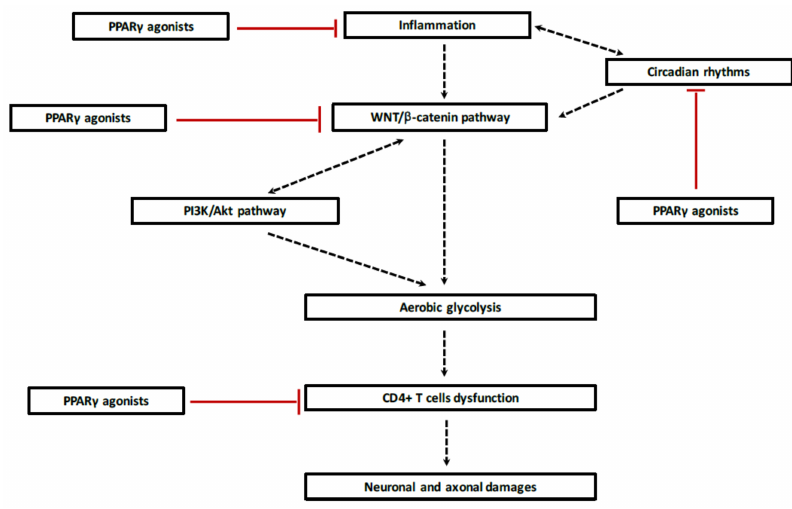
Figure 5. Potential PPAR γ agonists treatment approach in demyelination. During acute phase, inflammation processes, activated by disruption of circadian rhythms, lead to release of several cytokines and pro-inflammatory factors which stimulate the canonical WNT/ β -catenin pathway. Activation of the WNT ligands involves WNT target genes that are responsible for the initiation of the shunt of the tricarboxylic acid (TCA) resulting in aerobic glycolysis instead of oxidative phosphorylation. Lactate production, the main factor of energy metabolism alteration, and its release out the cells enhance CD4 + T cells dysfunction which aggravates MS pathogenesis, neuronal and axonal damages. Using PPAR γ agonists could be interesting because of their four interactions in the demyelination cascade. First, PPAR γ agonists directly inhibits neuroinflammation by inhibiting cytokines and inflammatory factors release. Secondly, PPAR γ agonists can regulate circadian clocks, such as Bmal1, to decrease inflammatory factors release and to target WNT ligands. Third, their opposed interaction with the canonical WNT/ β -catenin pathway can prevent the initiation of aerobic glycolysis process and then the energy metabolism reprogramming enable MS. At last, PPAR γ agonists have neuroprotective effects by targeting CD4 + T cells to prevent neuronal and axonal damages. Arrow: activation; T bar: